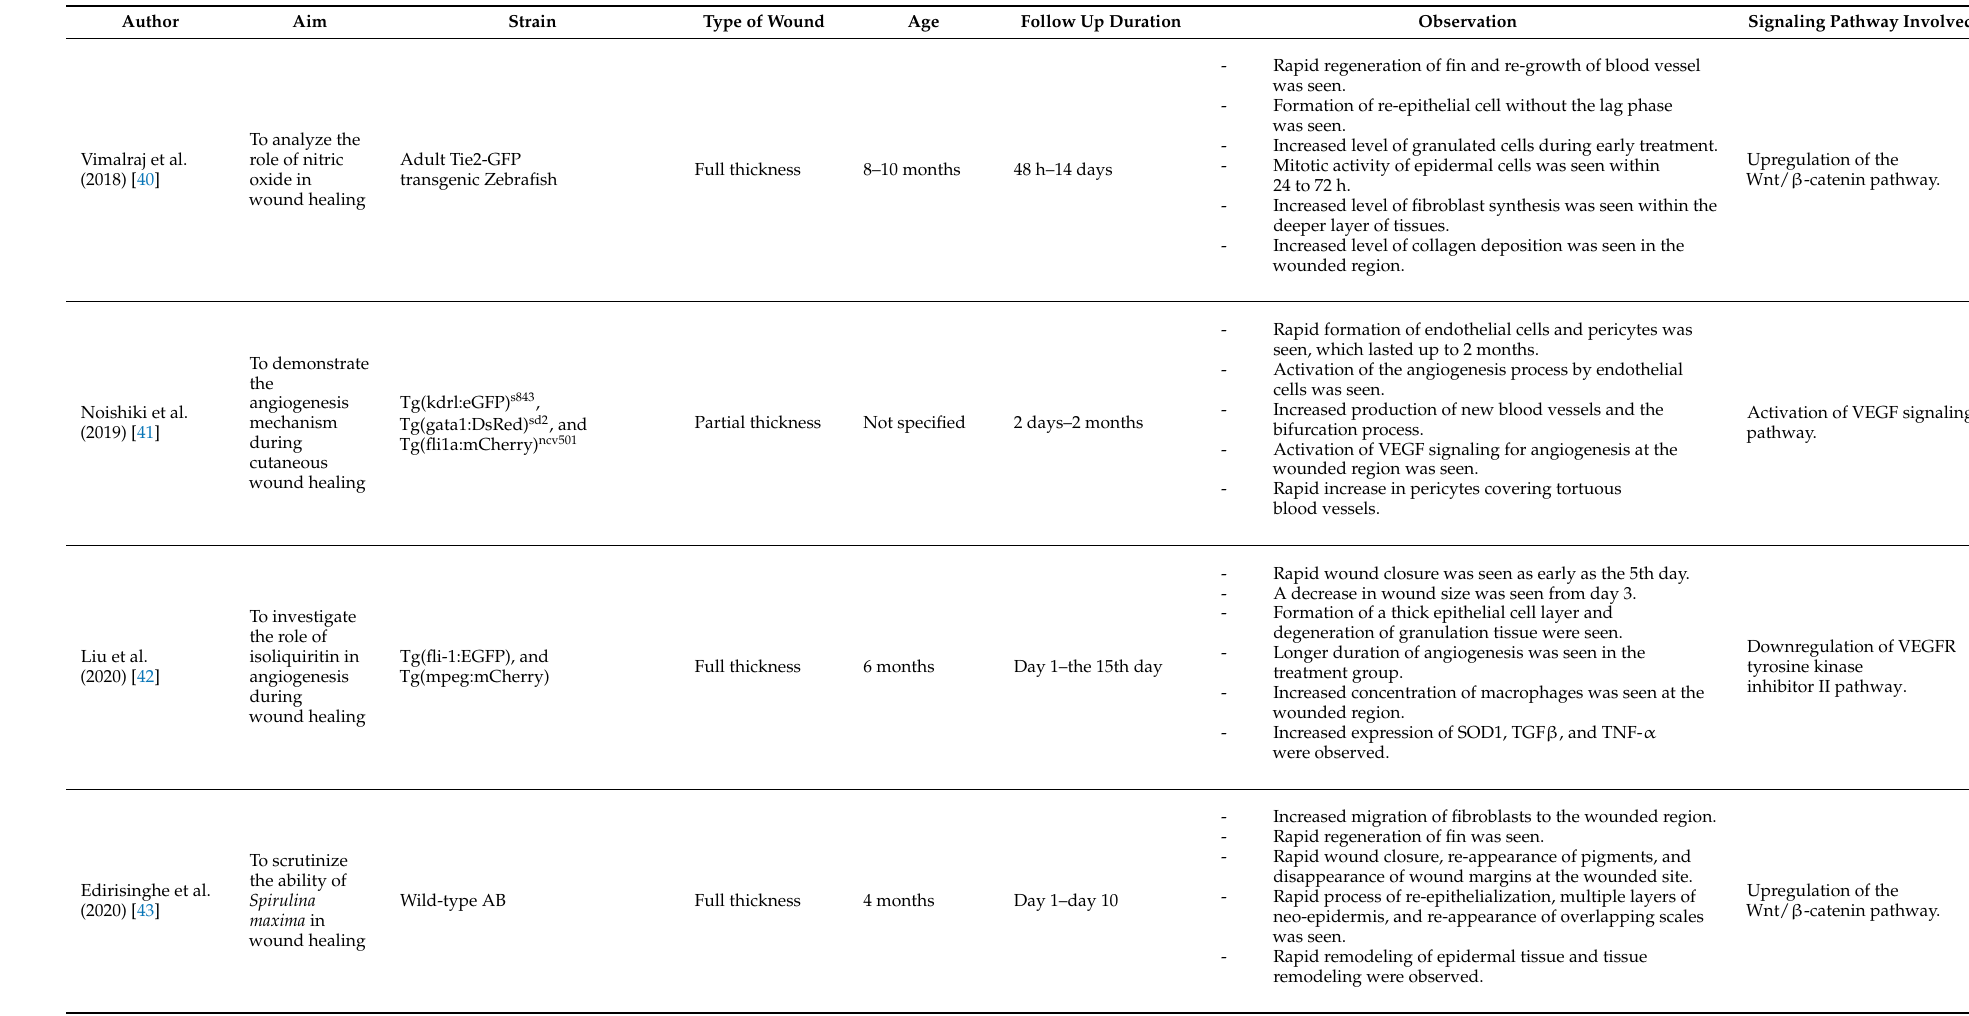
Upregulation of the Wnt/ β -catenin